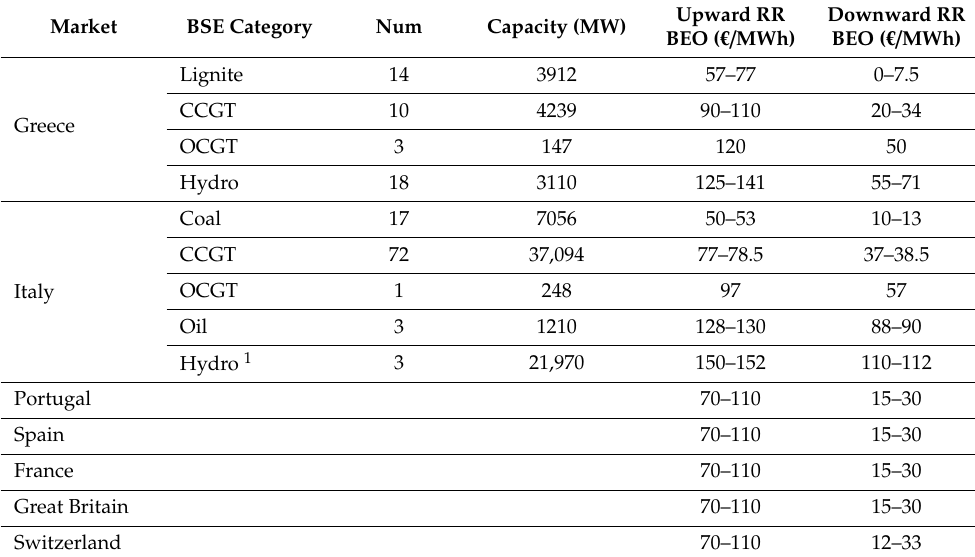
Table 1. Unit capacity in central dispatch markets and Balancing Energy Orders (BEOs) price range in all